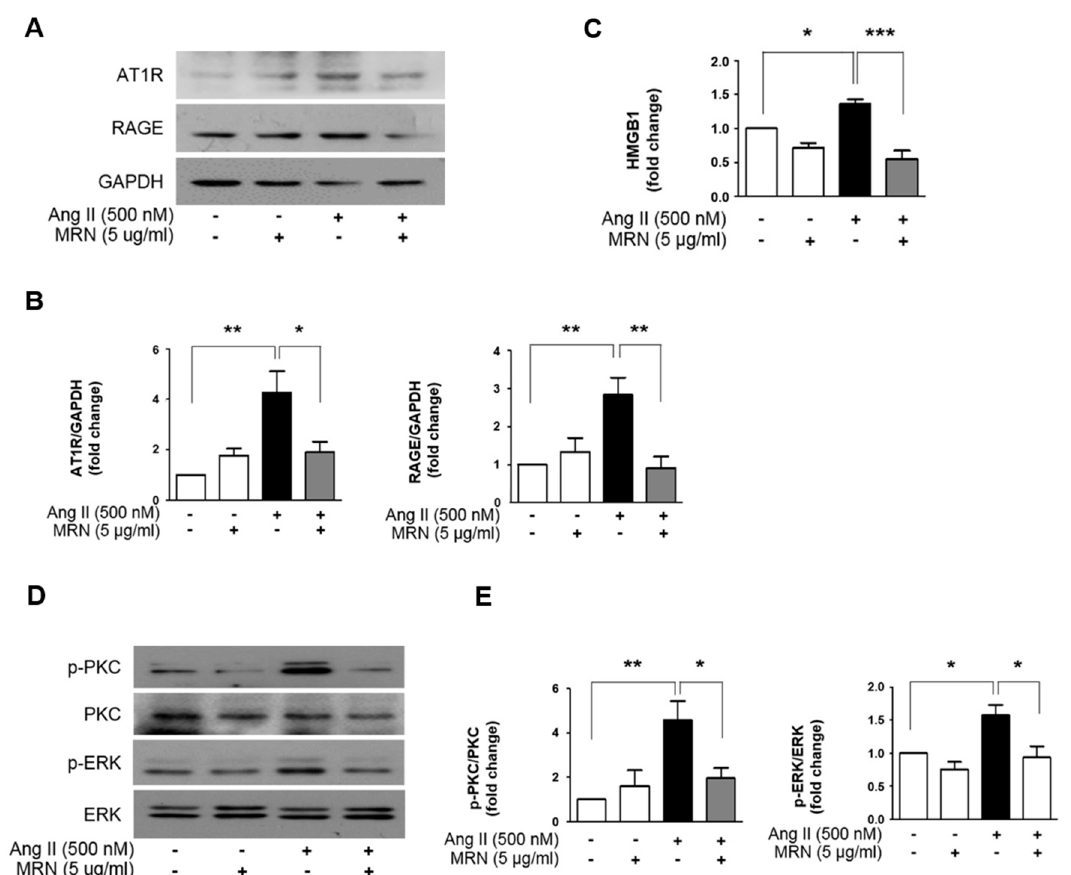
Figure 4. Nelumbo nucifera receptaculum extract (MRN) reduces protein kinase C (PKC)– extracellular-signal-regulated kinase (ERK) activation in Ang II-induced cardiomyocyte hypertrophy. H9c2 cells were treated with 500 nM Ang II for 24 h in the presence or absence of MRN. ( A , B ) Western blots of type I angiotensin receptor (AT1R) and RAGE expression are shown. Results are representative of five separate experiments. * p < 0.05, ** p < 0.01, *** p < 0.001. ( C ) The supernatant was collected and the release of HMGB1 was measured by ELISA. Results are representative of six separate experiments. * p < 0.05, ** p < 0.01. ( D , E ) H9c2 cells were treated with 500 nM Ang II in the presence or absence of MRN for 20 min and analyzed by western blotting. The values of the relative p-PKC and p-ERK bands were normalized to the PKC and ERK bands to represent the relative abundance of the p-PKC and p-ERK protein, respectively. Results are representative of four separate experiments. * p < 0.05, ** p < 0.01. The bars represent the mean ± SEM.